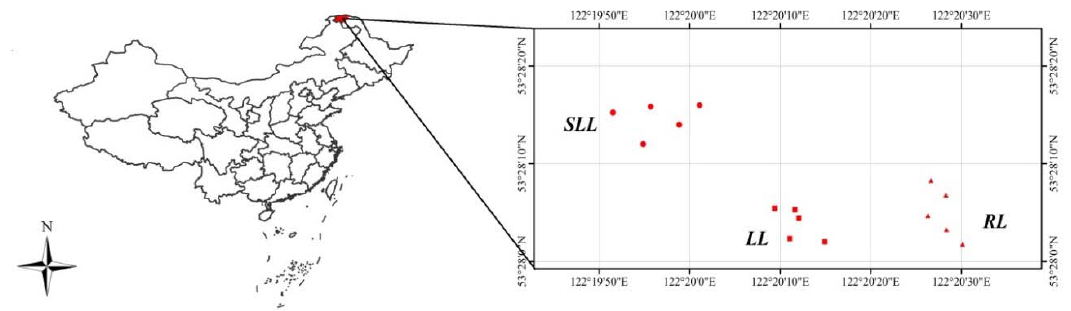
Figure 1. Representation of the study site. RL: Rhododendron simsii-Larix gmelinii forest, LL: Ledum palustre-Larix gmelinii forest and SLL: Sphagnum-Bryum-Ledum palustre-Larix gmelinii forest.